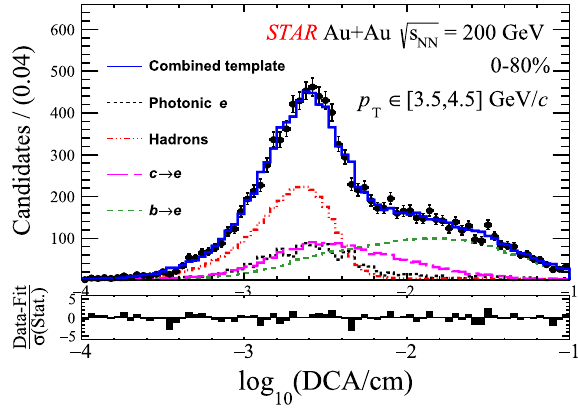
Fig. 4 Decay-electron log 10 (DCA/cm) distributions for different heavy flavor hadron species with an electron p T > 2.0GeV/ c